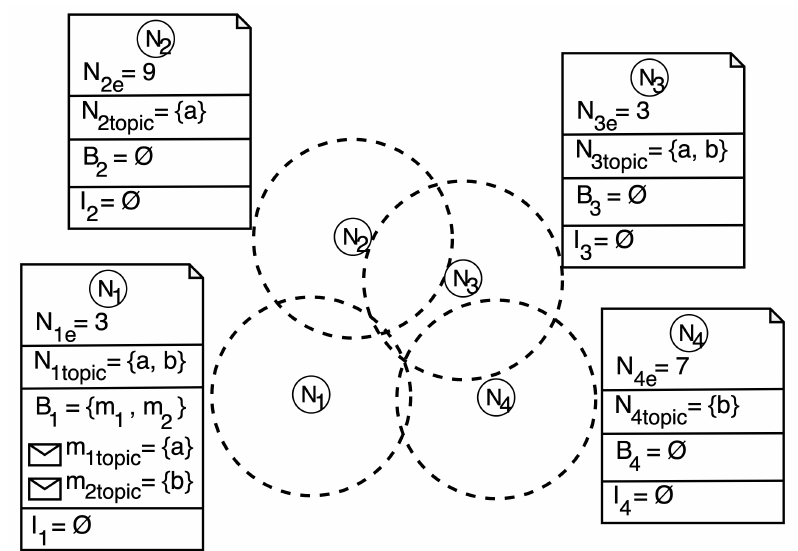
Figure 2. Encounter between